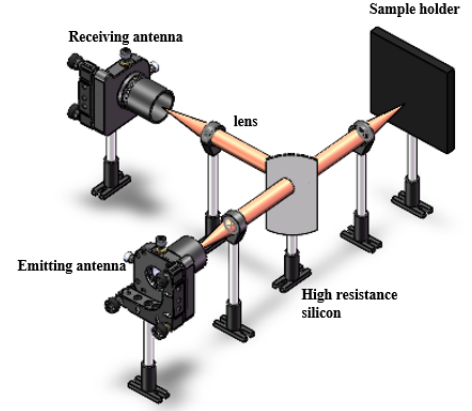
Figure 1. Schematic diagram of the experimental setup.